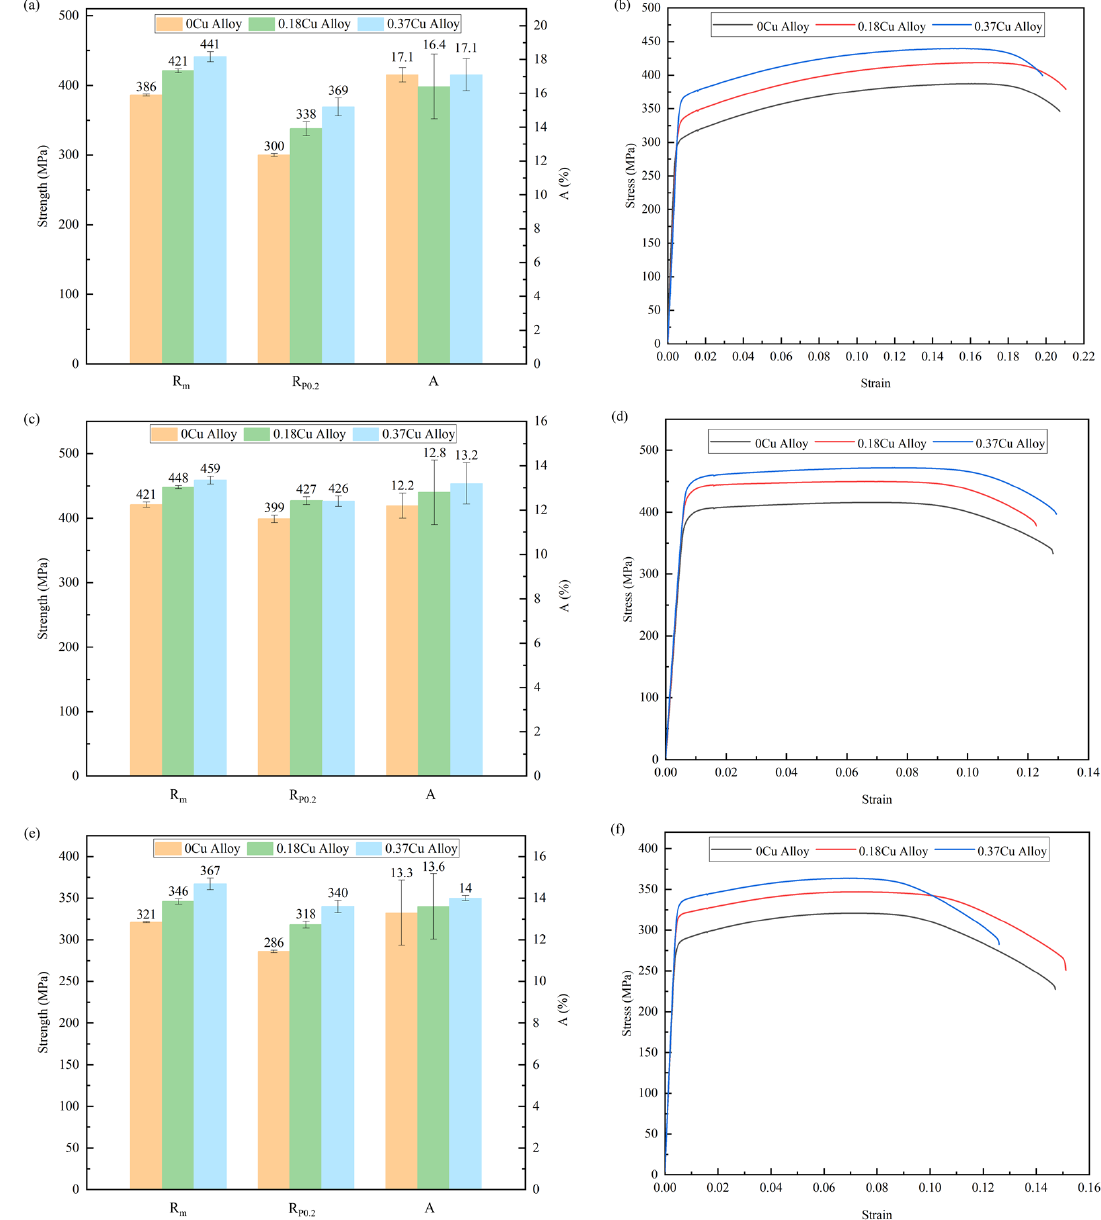
Figure 3. Tensile properties of three alloys at di ff erent aging stages. ( a , b ) Initial aging; ( c , d ) peak timeliness; ( e , f )